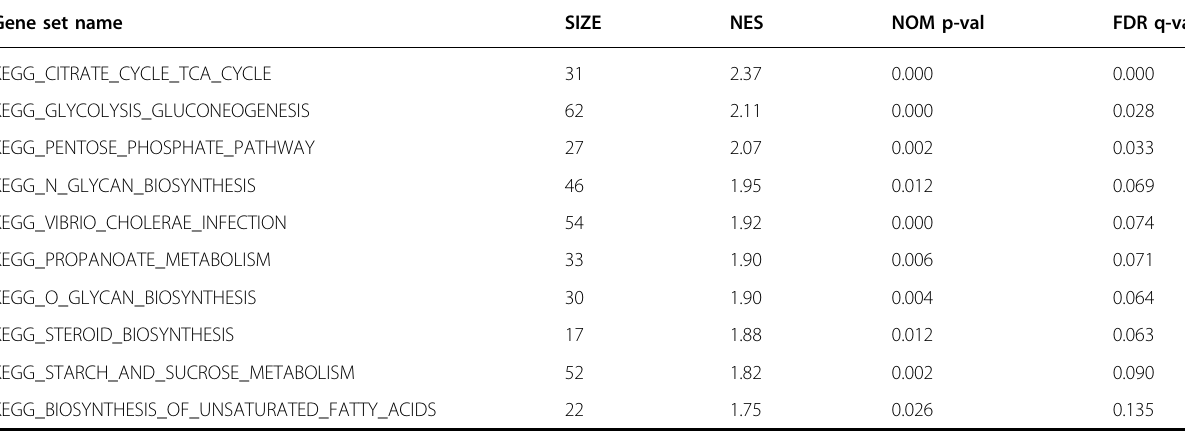
Table 1 Gene sets enriched in phenotype high based on TCGA (Top